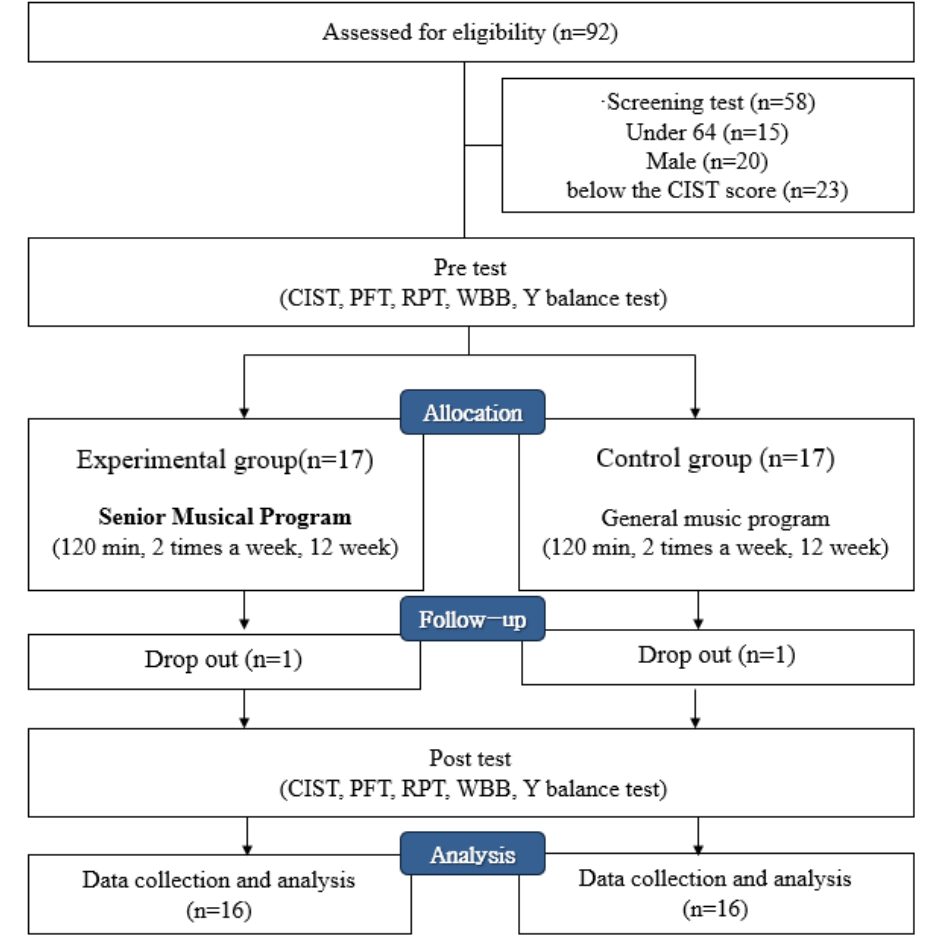
Figure 2. Flow chart of the study.